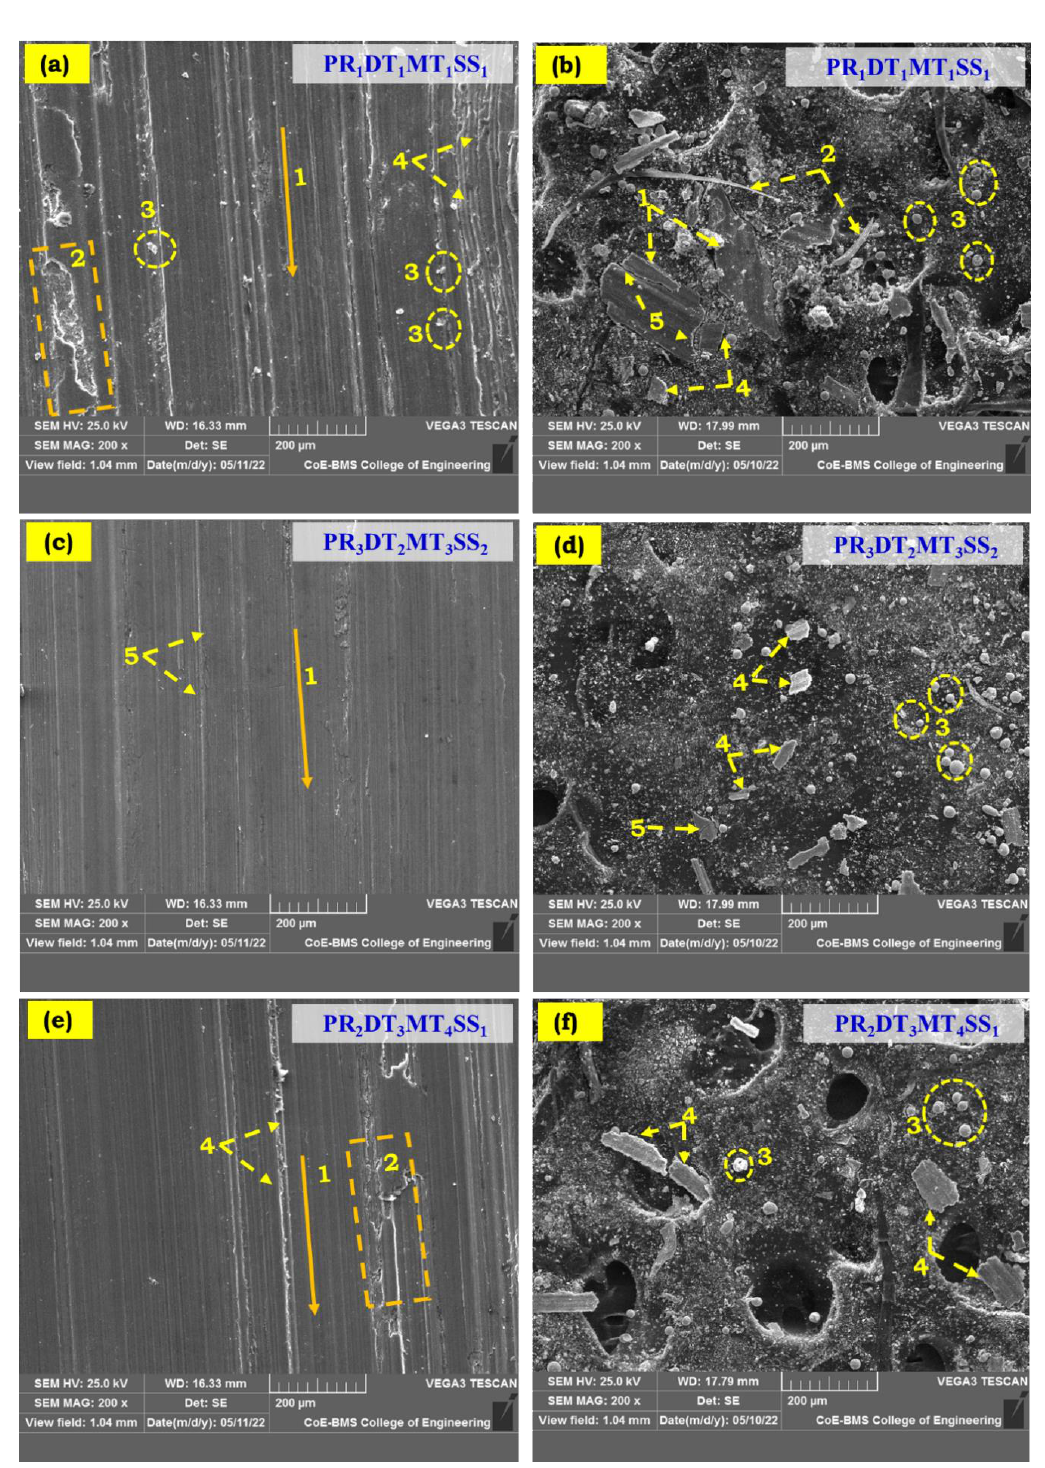
Figure 10. Wear Track and Wear Debris SEM images of the present investigation. ( a , b ) PR 1 DT 1 MT 1 SS 1 Condition; ( c , d ) PR 3 DT 2 MT 3 SS 2 Condition; ( e , f ) PR 2 DT 3 MT 4 SS 1 Condition.